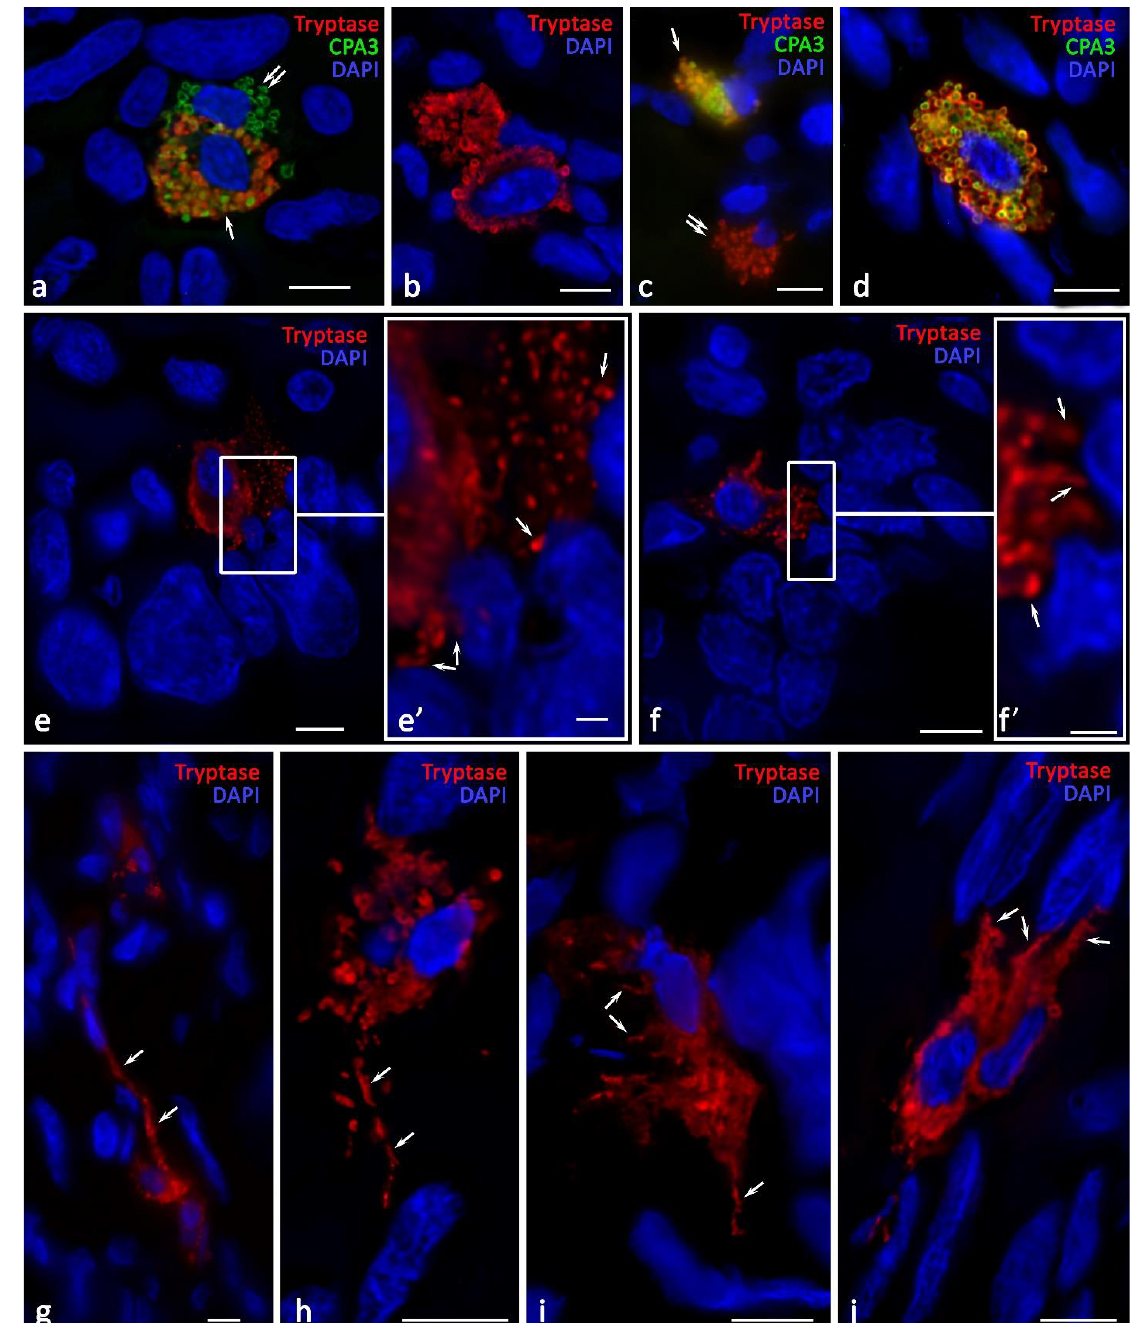
Figure 4. Histotopographic features of ovarian mast cells under endometrioid cyst development. ( a – c ) Colocalization of MCs with different phenotypes: Tr + CPA3 + (indicated by an arrow) and Tr- CPA3 + (indicated by a double arrow) ( a ), two MCs without CPA3 ( b ), Tr + CPA3 + (indicated by an arrow) and Tr + CPA3 − (indicated by a double arrow) ( c ). ( d ) A large MC with tryptase and CPA3